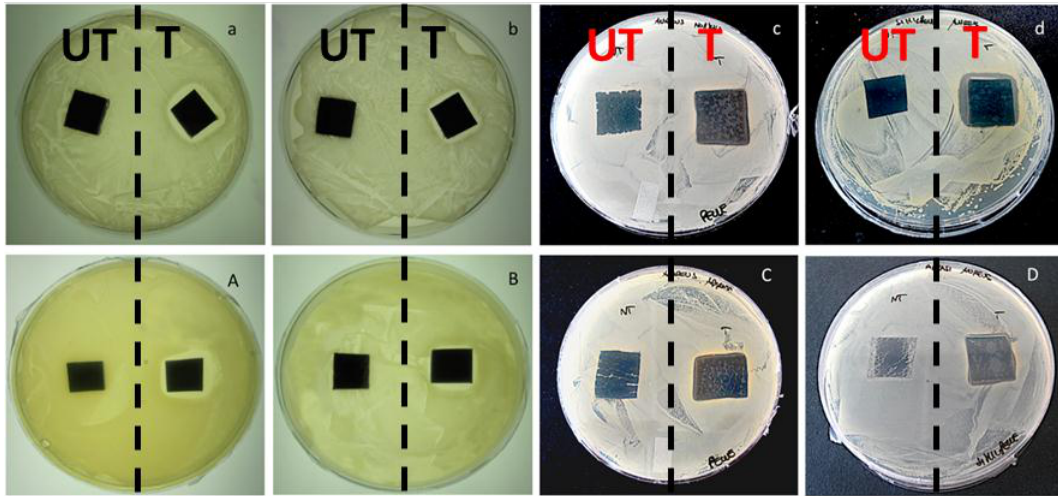
Figure 9. Agar diffusion tests on E. coli before (a,b) and after (A,B) surface abrasion on pristine and Ag-treated leather ( a , A ), pristine and Ag-treated leatherette ( b , B ). Agar diffusion tests on S. aureus before ( c , d ) and after ( C , D ) surface abrasion on pristine and silver-treated leather ( c , C ), pristine and silver-treated leatherette ( d , D ). Dashed lines separate untreated samples (labeled as UT) from Ag-modified ones (labeled as T), present respectively on the left and on the right of each Petri dish.